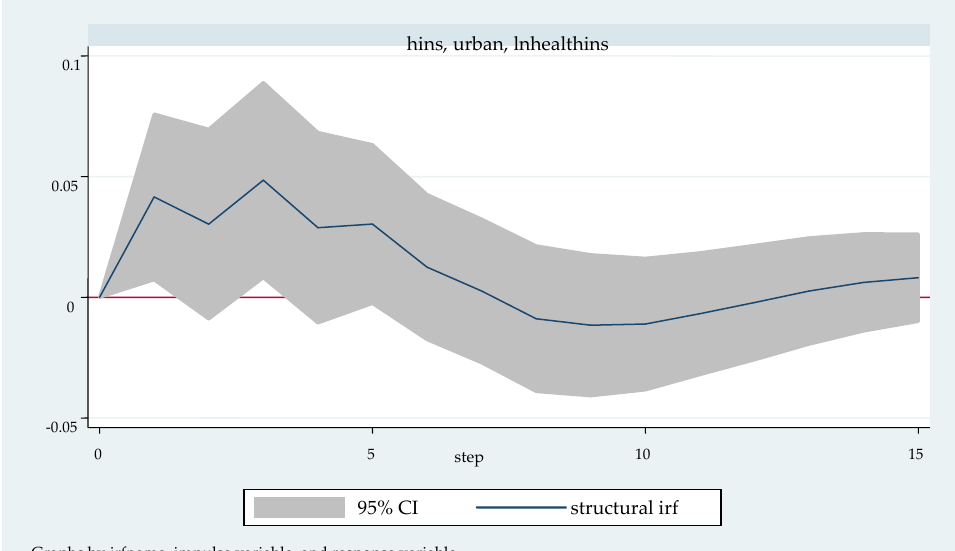
Figure 4. Impulse response function diagram of “lnhealthins” impacted by “urban”.